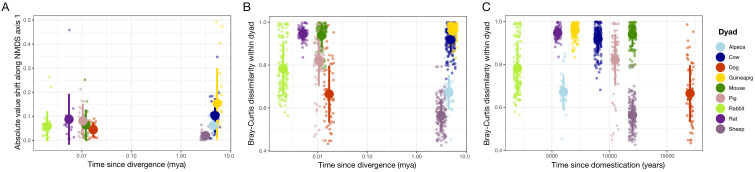
Relatedness was correlated with ordination shifts but not dissimilarity within a dyad.(A) The absolute value of shifts along nonmetric multidimensional scaling (NMDS) axis 1 for individuals relative to their dyad average was higher for dyads with a greater time since divergence (p=0.012, rho = 0.19, Spearman correlation). (B, C) Average Bray–Curtis dissimilarity between members of wild–domestic dyads was not correlated with time since divergence (p=0.380; B) or time since domestication (p=0.854; C). Large circles are means; bars show standard deviations.